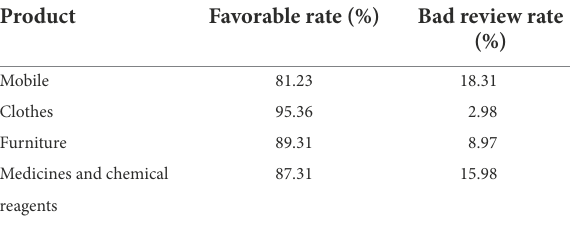
TABLE 2 Frequency of emotional tendency of product